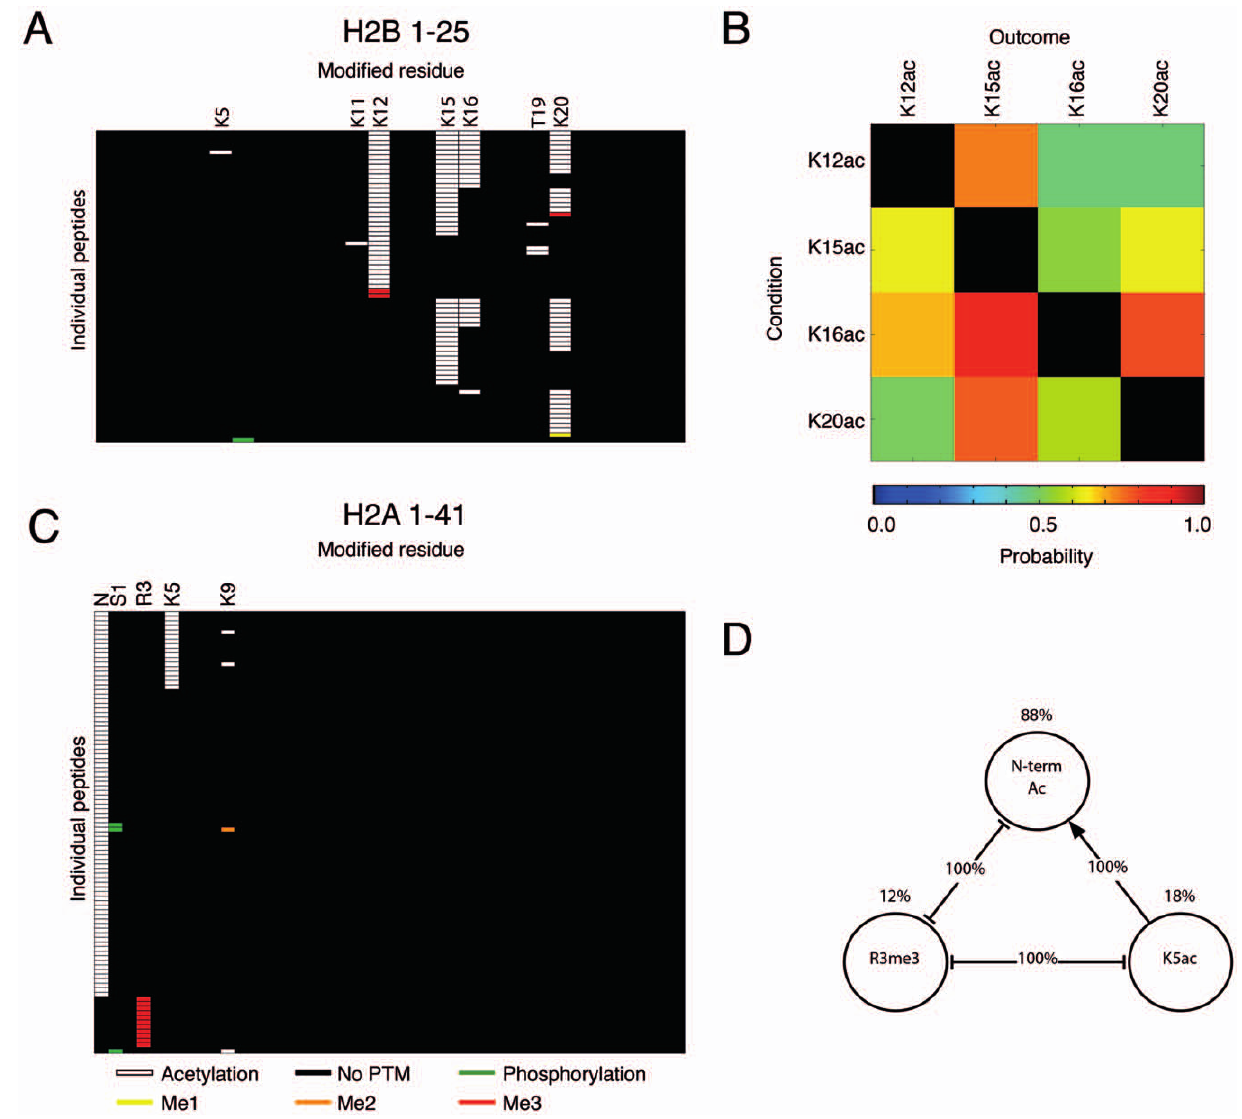
Figure 3. Combinatorial patterns on H2A and H2B. Summary of N-terminal H2B and H2A combinatorial codes identified using ETD-MS. Each line represents an individual H2B 1–25 ( A ) or H2A 1–41 ( C ) peptide. Probability of co-occurrence of individual PTMs on H2B 1–25 determined by an association rule data-mining algorithm ( B ). The condition (left rows) is when a specific PTM is observed on H2A/H2B, and the outcome (top columns) is the probability (indicated by a heat plot) that a second or several PTM(s) are observed at the same time on the same histone molecule. Diagram depicting the relationship between three PTMs on H2A 1–41 ( D ). N-term Ac, K5ac and R3Me3 were either mutually exclusive or always seen in combination. The frequency of each PTM is indicated by the % above the circle, connections indicate the derived rule and its % occurrence. For instance, when K5ac was present, N-term ac was also observed in 100% of cases (connected by arrow), but R3me3 was never observed. When R3me3 was observed, N-term acetylation or K5ac was never observed (100% of cases), suggesting mutual exclusion of N-term acetylation and R3me3, potentially due to steric hindrance or conformational changes induced by each PTM.